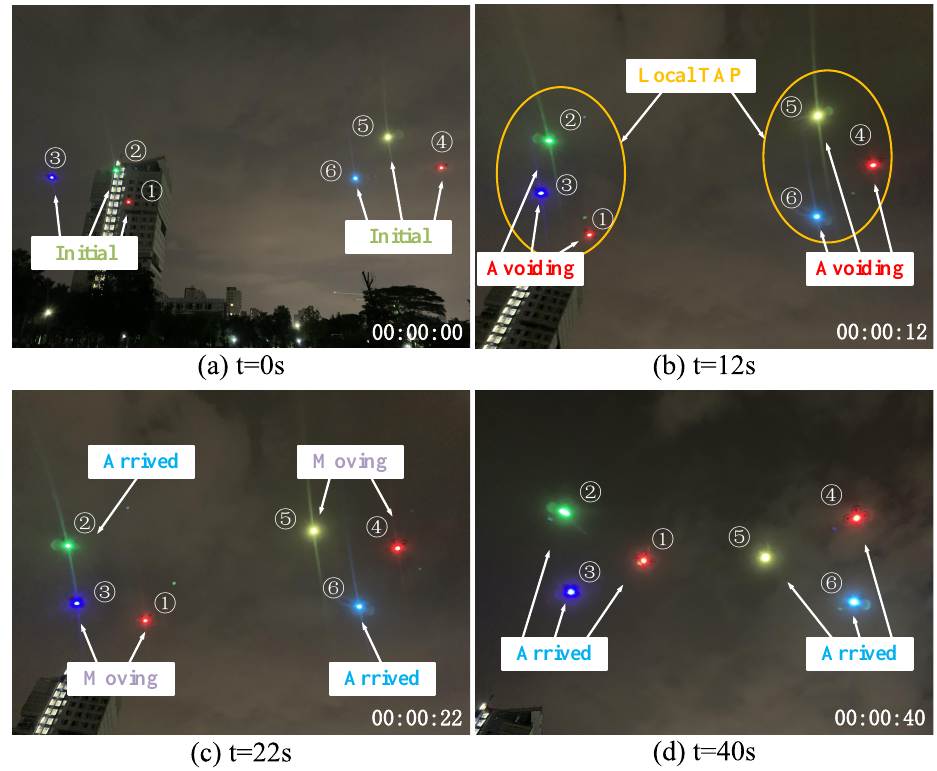
Figure 15. Onsite photos of the UAVs-LS with six quadrotors at 0, 28, 52, and 75